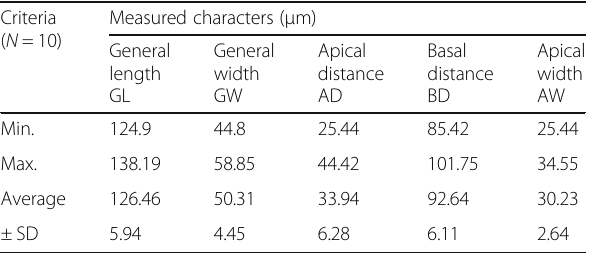
Table 2 Measured characters ( μ m) of TNV male genitalia Criteria ( N = 10)